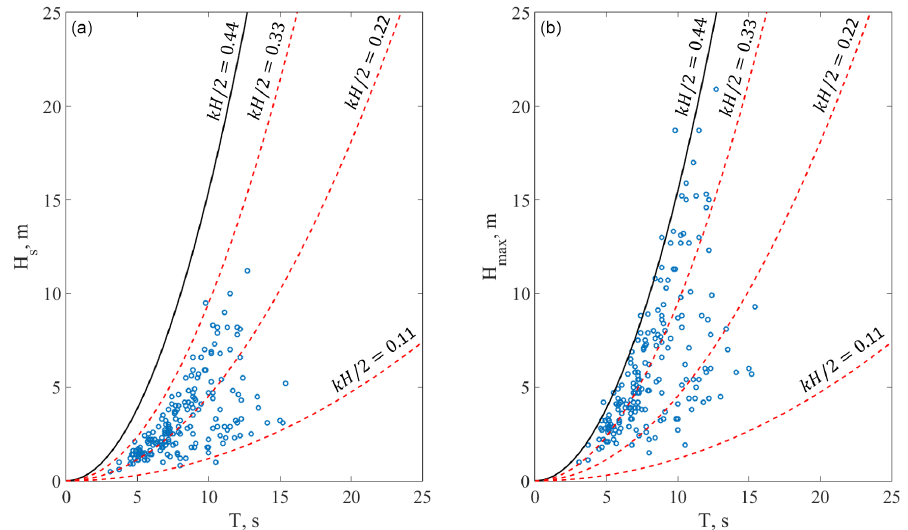
Figure 7. (a) Significant wave height versus wave period. (b) Individual maximum wave height versus wave period. Black line corresponds to the maximum steepness curve ( kH /2 = 0 . 44).